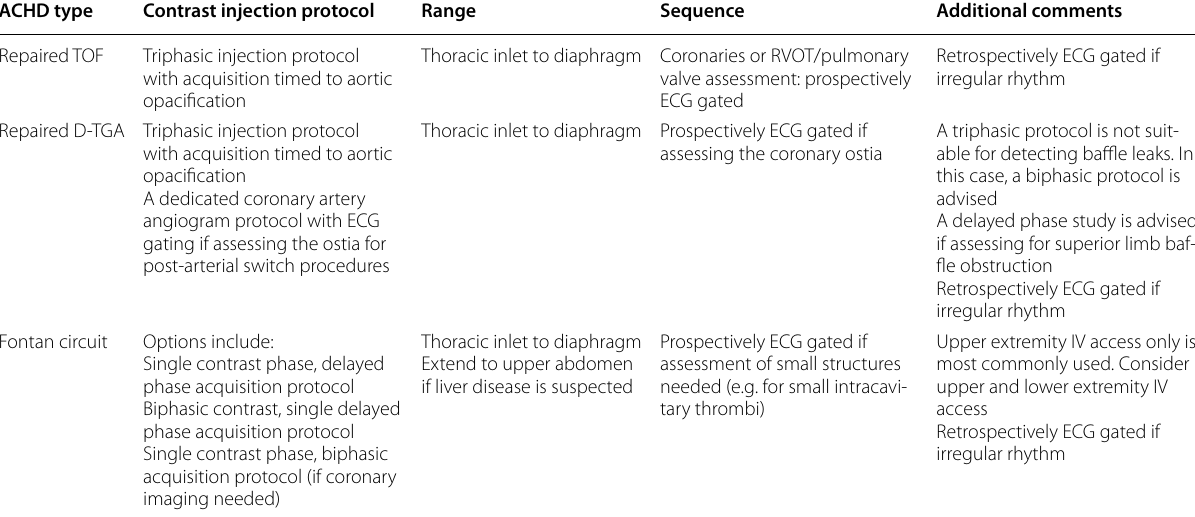
Table 1 Summary of suggested CT protocols by repaired defect